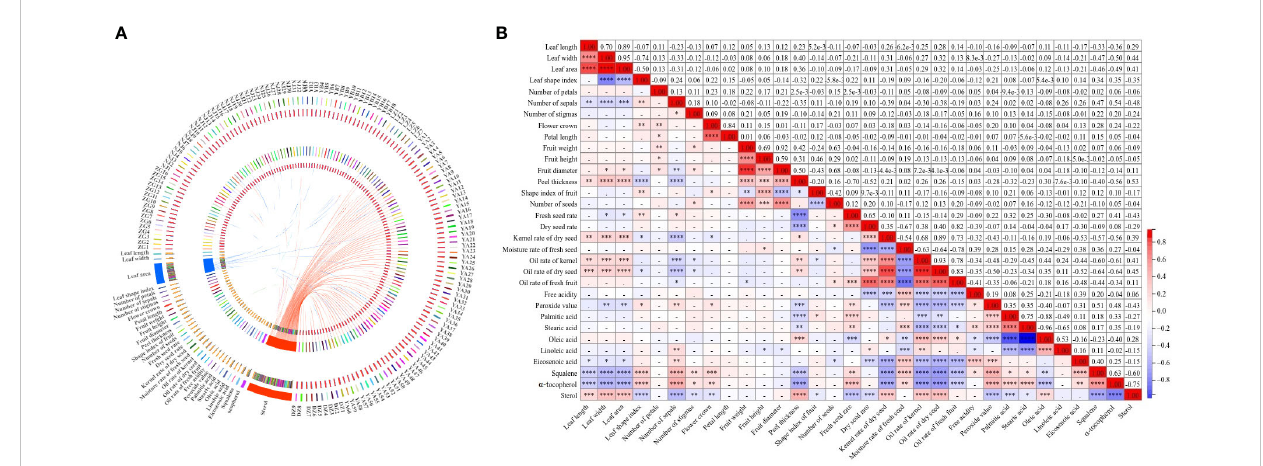
FIGURE 8 Correlation of 32 quantitative characteristics in 143 C . oleifera germplasm resources: (A) Circos visualization between traits and germplasm and (B) heat map for correlation analysis of – 32 quantitative characteristics. Note: ****0.0001, ***0.001, and **0.01 — extremely signi fi cant correlation; *0.05 — signi fi cant correlation.